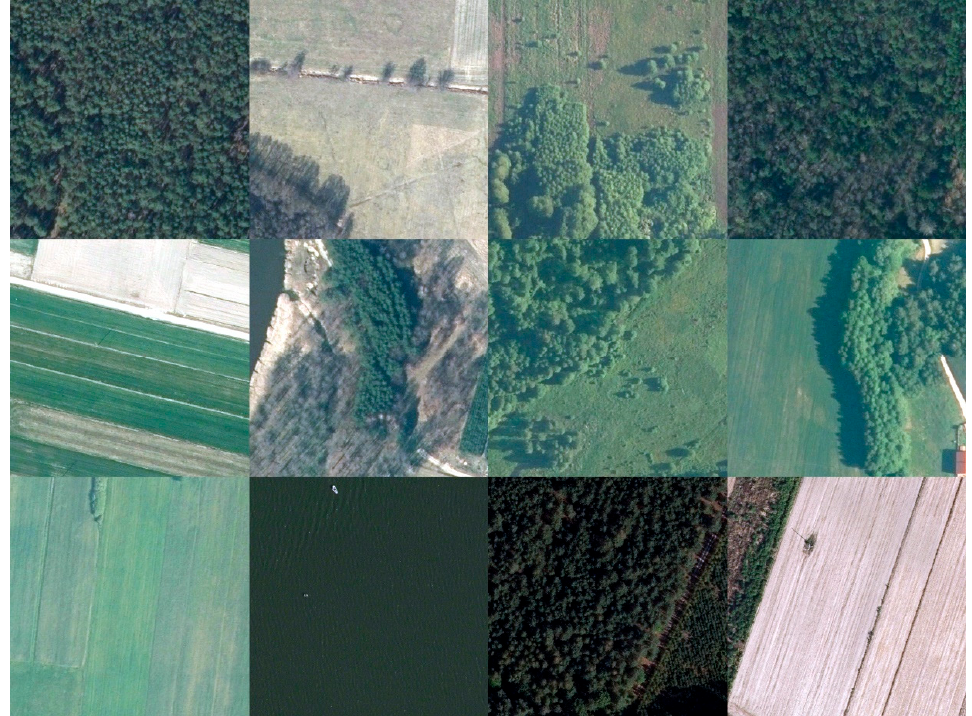
Figure 3. Examples of the Pilica River region dataset samples (512 px × 512 px patches). From the upper left corner: forest and a barely visible forest path outline, farmlands cut by a sandy road planted with trees, forest with an adjacent land abandonment, forest, farmlands, river valley, forest and an overgrown meadow, forest with clearly outlined shadow and a dirt road, farmlands, water reservoir, forest cut by a road, recently plowed farmland with balks, and a young forest. During the preprocessing phase each image was split into 128 px × 128 px, 256